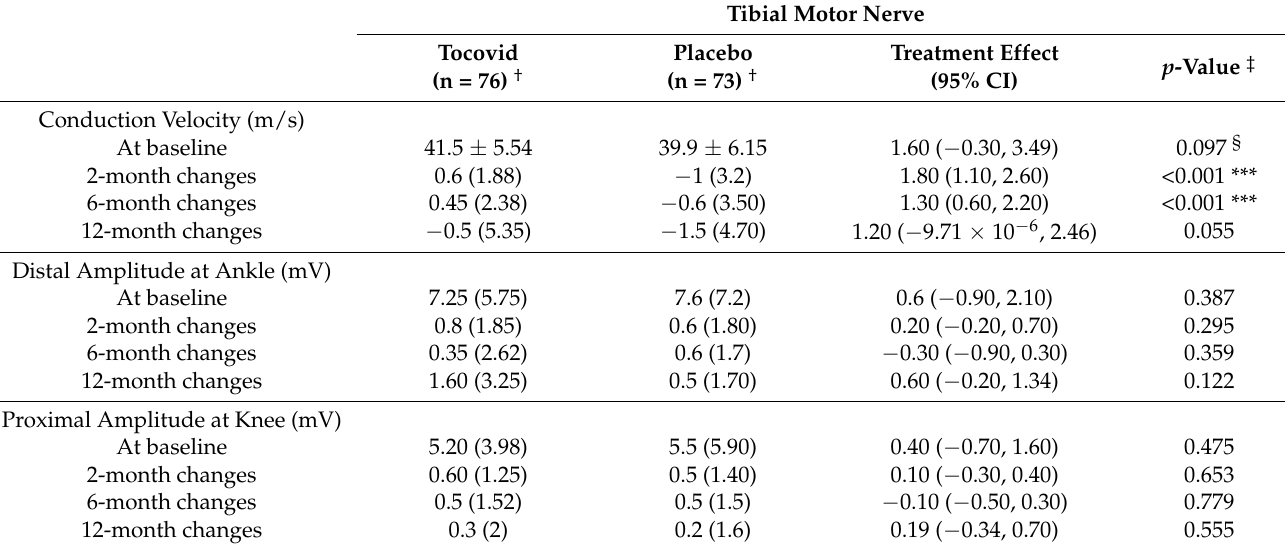
Table 4. Comparison of tibial motor nerve conduction parameters between Tocovid and placebo groups. Tibial Motor